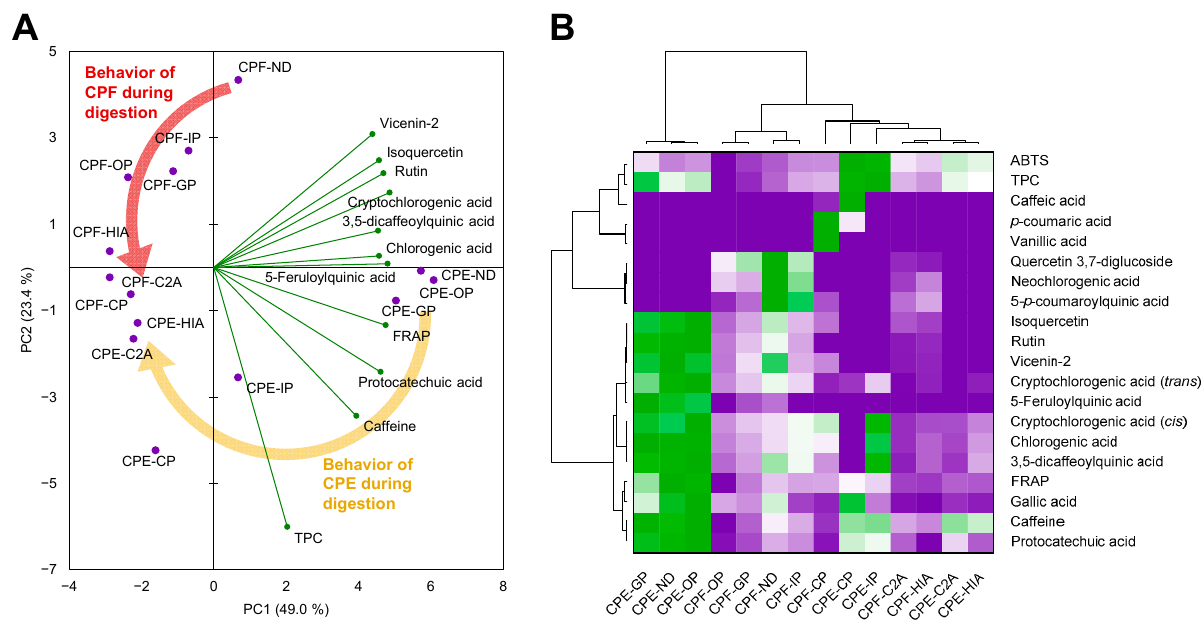
Figure 2. Biplot (scores of samples and load factors of each variable) of the principal component analysis (PCA) ( A ) and agglomerative hierarchical cluster analysis coupled to heatmap (from the lowest ( ) to the highest ( ) value for each parameter) ( B ) illustrating the behavior of phenolic compounds and caffeine from the coffee pulp during simulated gastrointestinal digestion.